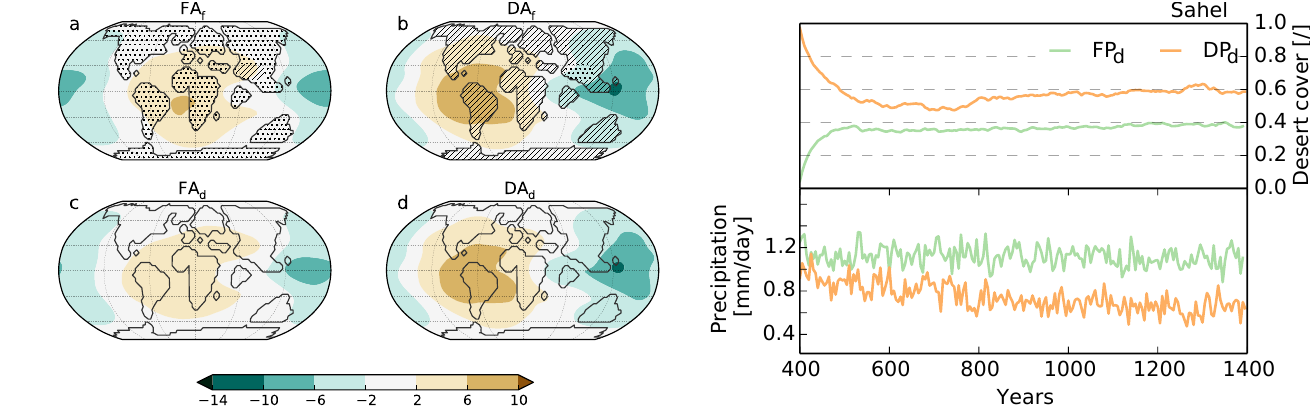
Figure 8. Velocity potential at 200hPa at the end of the FA f sim- ulation and DA f simulation (a–b) and at the end of the FA d sim- ulation and DA d simulation (c–d) . The average over the last 30 years of each simulation is considered. Brown colours indicate to a positive velocity potential, upper-air convergence, and subsidence. Green colours indicate to a negative velocity potential, upper-air di- vergence, and rising.